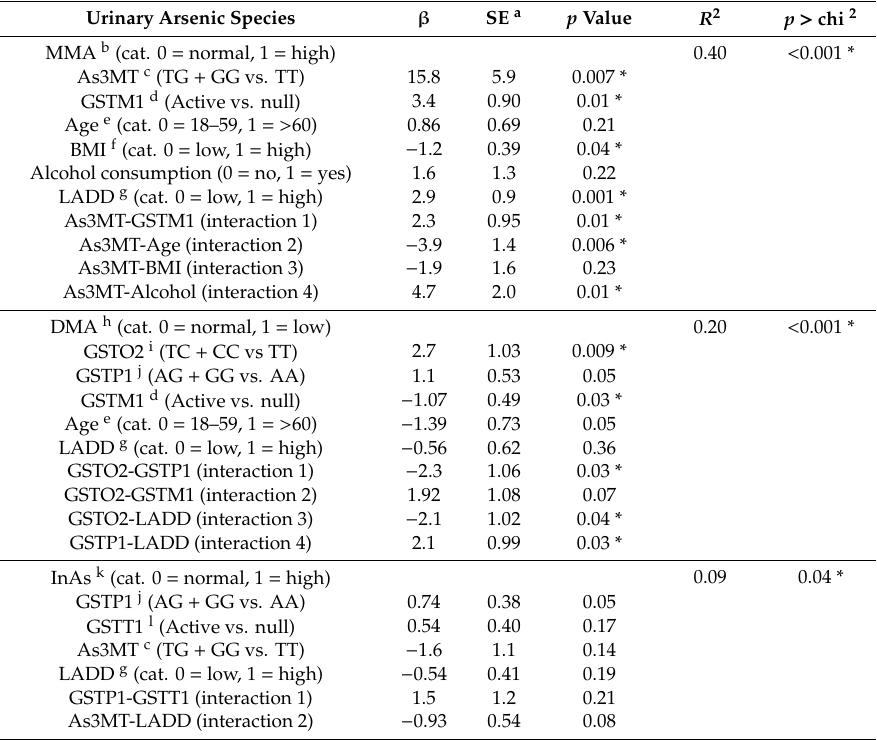
Table 4. Multivariate analyses of polymorphic variants on relative urinary arsenic metabolites, adjusted by